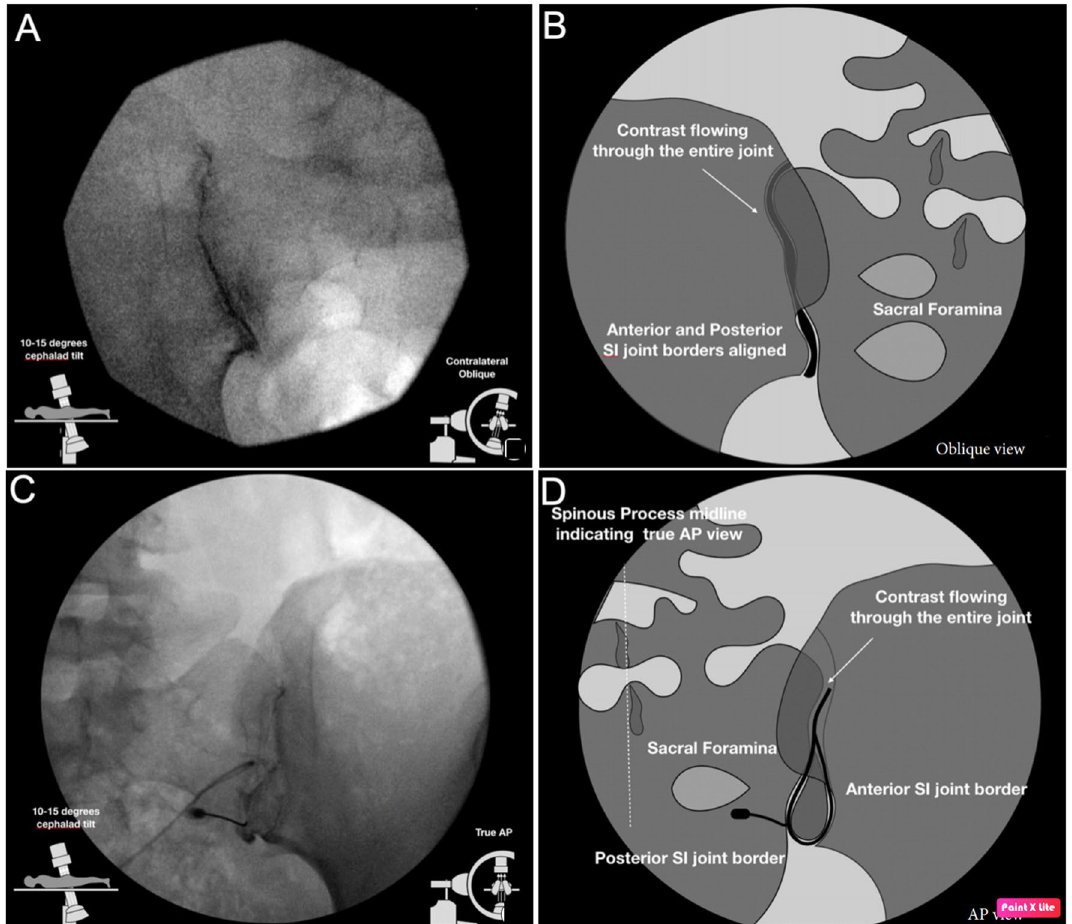
Fig. 8 Oblique technique fluoroscopic view ( A ) and graphical illustration ( B ). In the oblique approach, the C-arm is rotated in a contralateral manner until the 2 joint lines become superimposed. Then, one would target the inferior segment of this superimposed image, as the superior sacroiliac (SI) joint space is composed of interosseous ligaments. Antero-posterior technique fluoroscopic view ( C ) and graphical illustration ( D ). In the anterior–posterior (AP) approach, image is taken with 5°–15° cephalad tilt from the vertical of the fluoroscopy machine reveals a joint with 2 separately visible anterior and posterior joint lines. The anterior and posterior parts of the sacroiliac (SI) joint were delineated as lateral and medial joint spaces, respectively. (Reproduced from